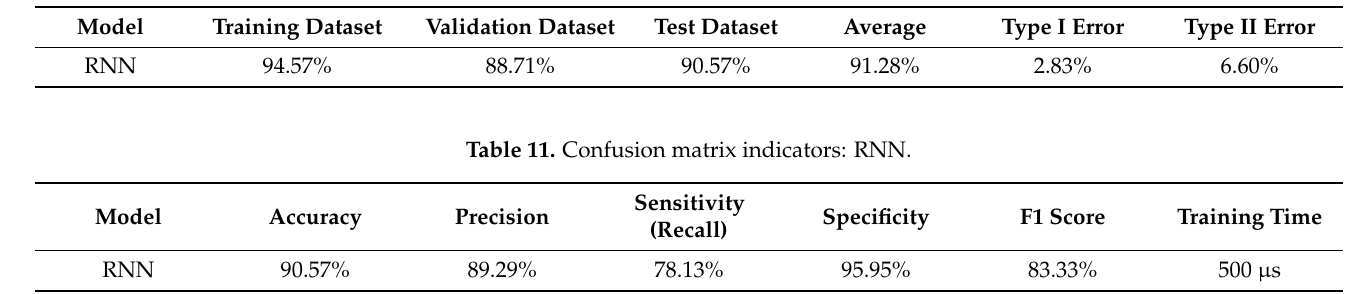
Table 10. Accuracy of the RNN model.